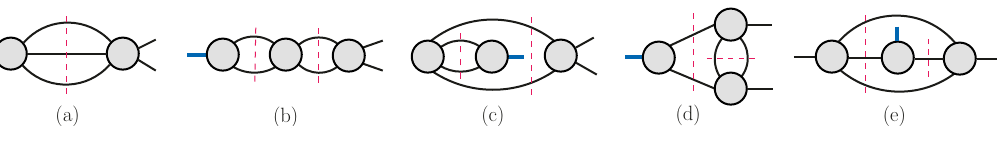
Figure 4 . The cuts needed in the 2-loop 2-point form factor calculation.